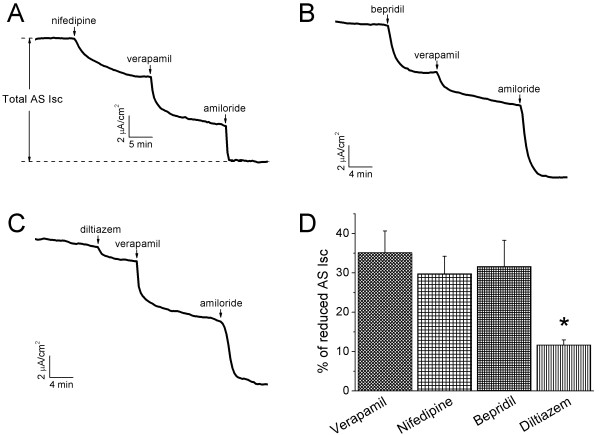
Effects of CCB compounds on transepithelial short-circuit currents (Isc) in intact H441 monolayers. (A-C) Typical traces. 200 μM nifedipine (A), 10 μM bepridil (B) or 50 μM diltiazem (C) was added to the basolateral compartment followed by verapamil. Amiloride (100 μM, apical side) was finally applied to inhibit residual amiloride-sensitive currents. Arrows show the time point of addition. Total AS Isc is the difference between the Isc level before CCB and the amiloride-insensitive fraction, as indicated by a pair of vertical arrows. (D) CCB-sensitive fraction: CCB-inhibitable Isc/total AS Isc. One-way ANOVA. *P < 0.05 vs Verapamil. n = 3-10.